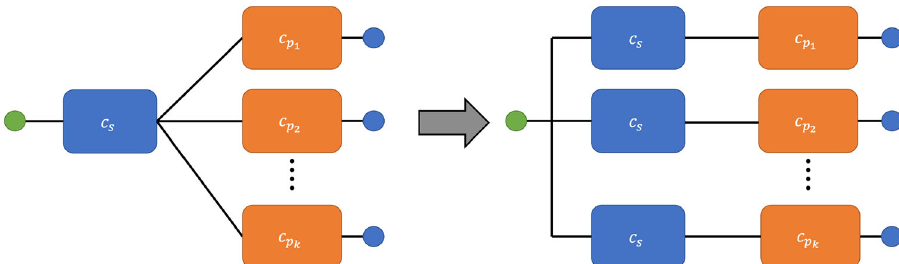
Fig. 3 A schematic representation of the parallel approximation. The parallel approximation preserves the number of paths and their lengths, but ignores overlap between the paths. In this example, the source node (in green) is connected to target nodes (in blue) by k branches of the network (represented by the orange boxes), each with concurrence c p . Each branch joins to a segment with concurrence c s (represented by the blue box). Under the parallel i approximation the network is transformed so that the k branches have no overlap with